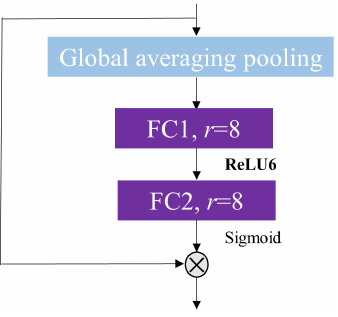
Figure 3. The attention mechanism.